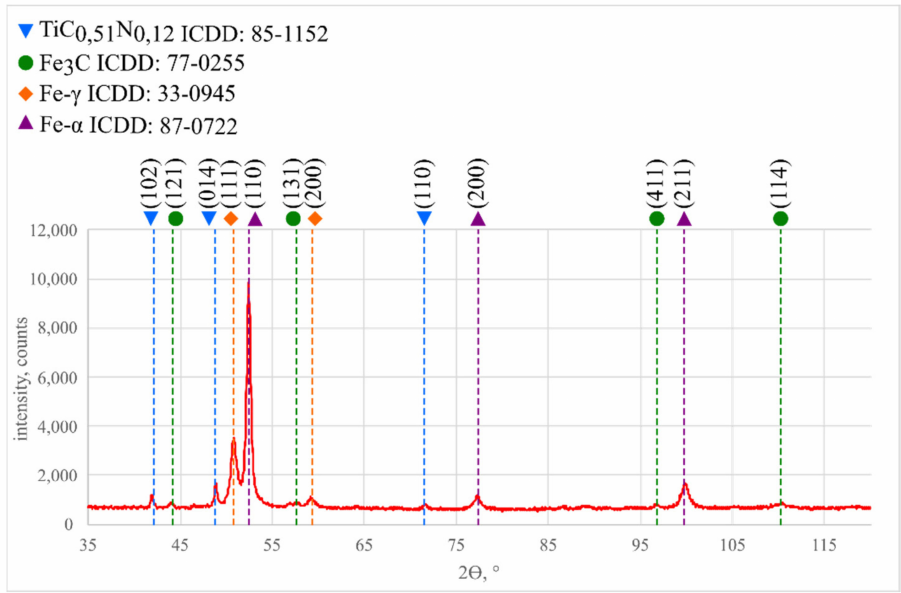
Figure 8. The XRD results of the representative homogeneous laser-alloyed surface